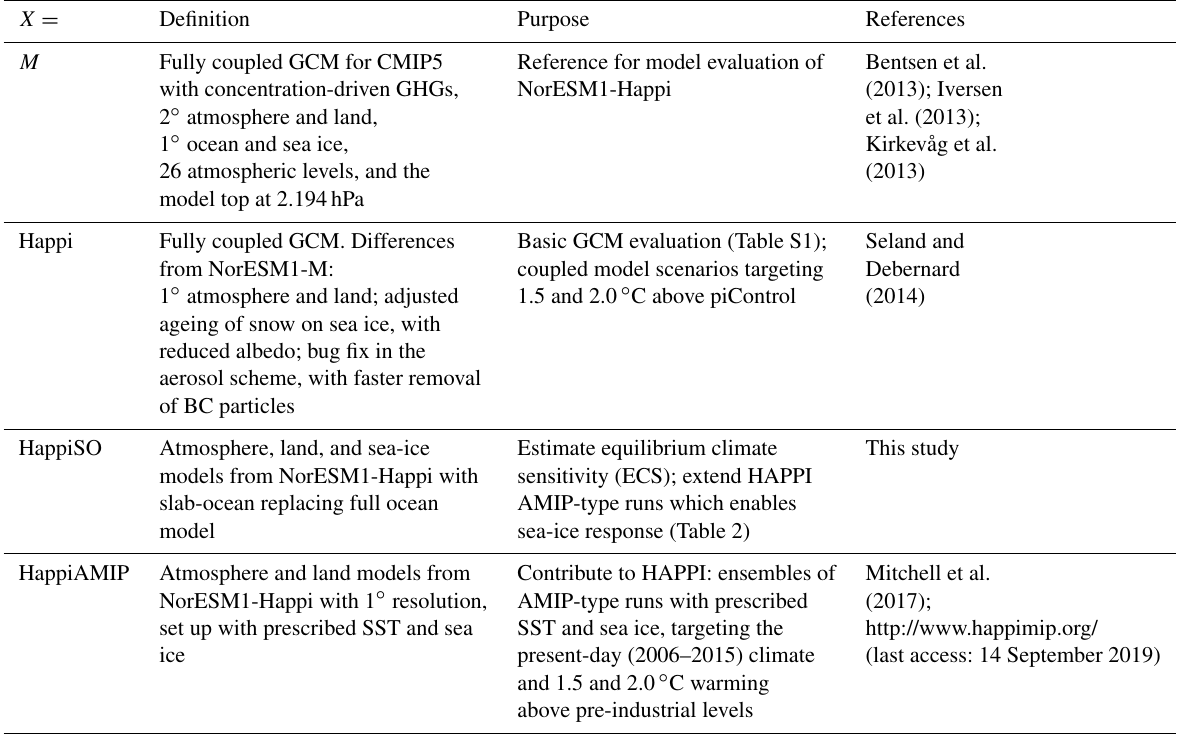
Table 1. Overview of the NorESM1-X versions referred to in this paper. X